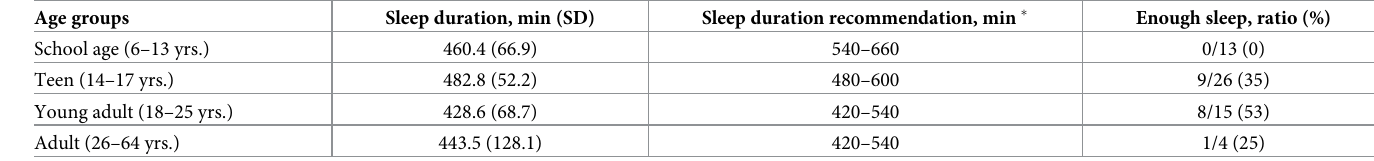
Table 4. Mean sleep duration, sleep duration recommendation and ratio of participants reaching recommendations for each age group.